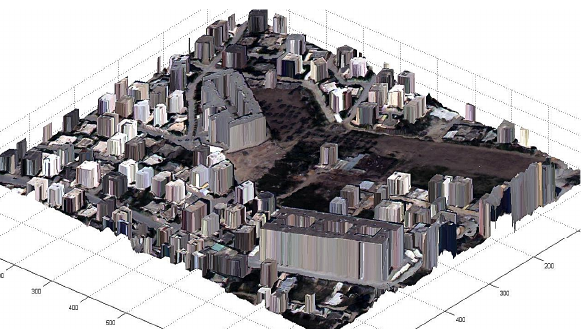
Figure 11: Superimposing of ortho rectified image on 3D pris- matic models (zoomed to a smaller